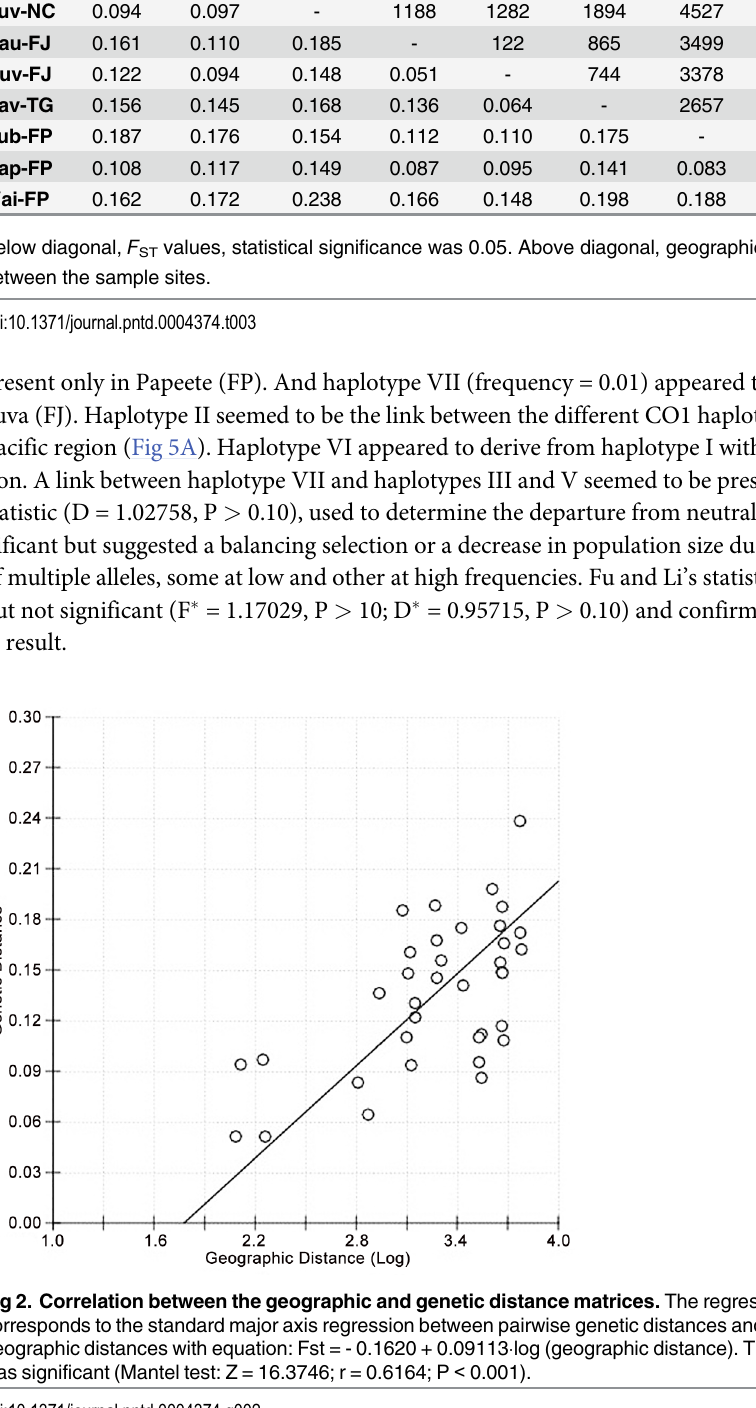
Table 3. Pairwise F ST values for the nine populations studied and geographic distances between the sampling sites (in km). Poi-NC Nou-NC